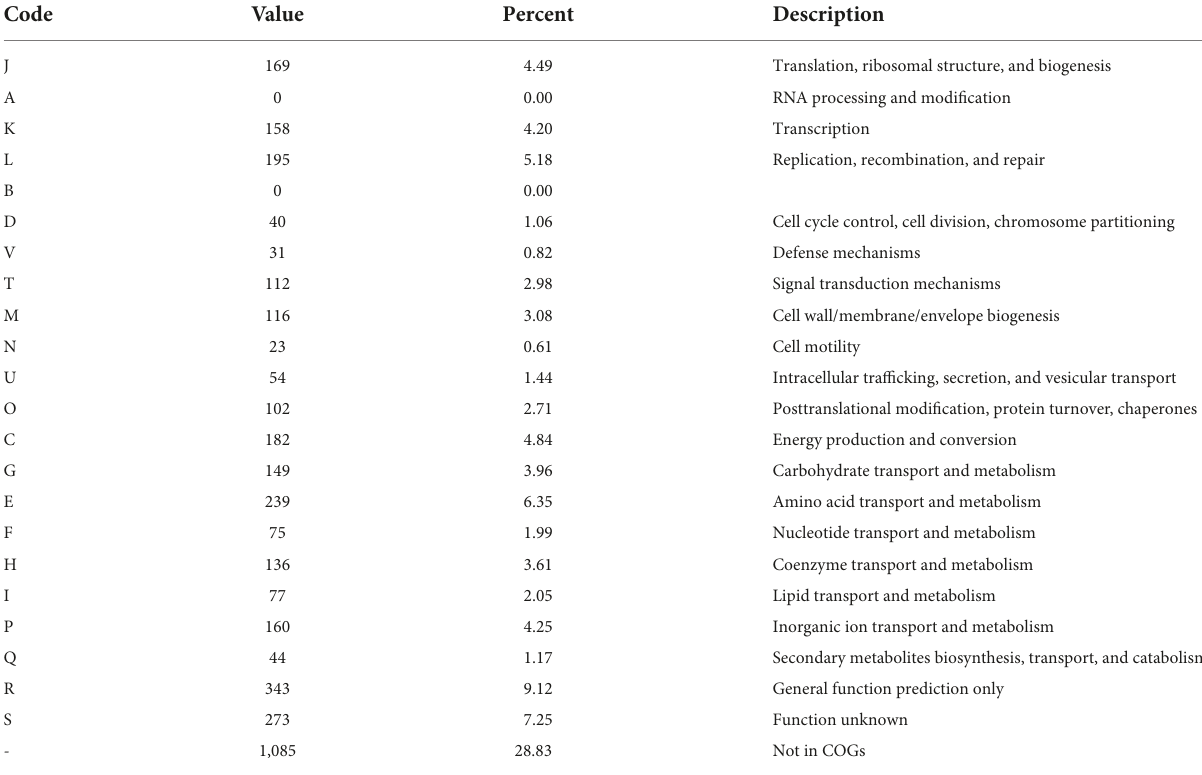
TABLE 3 Number of genes associated with general COG functional